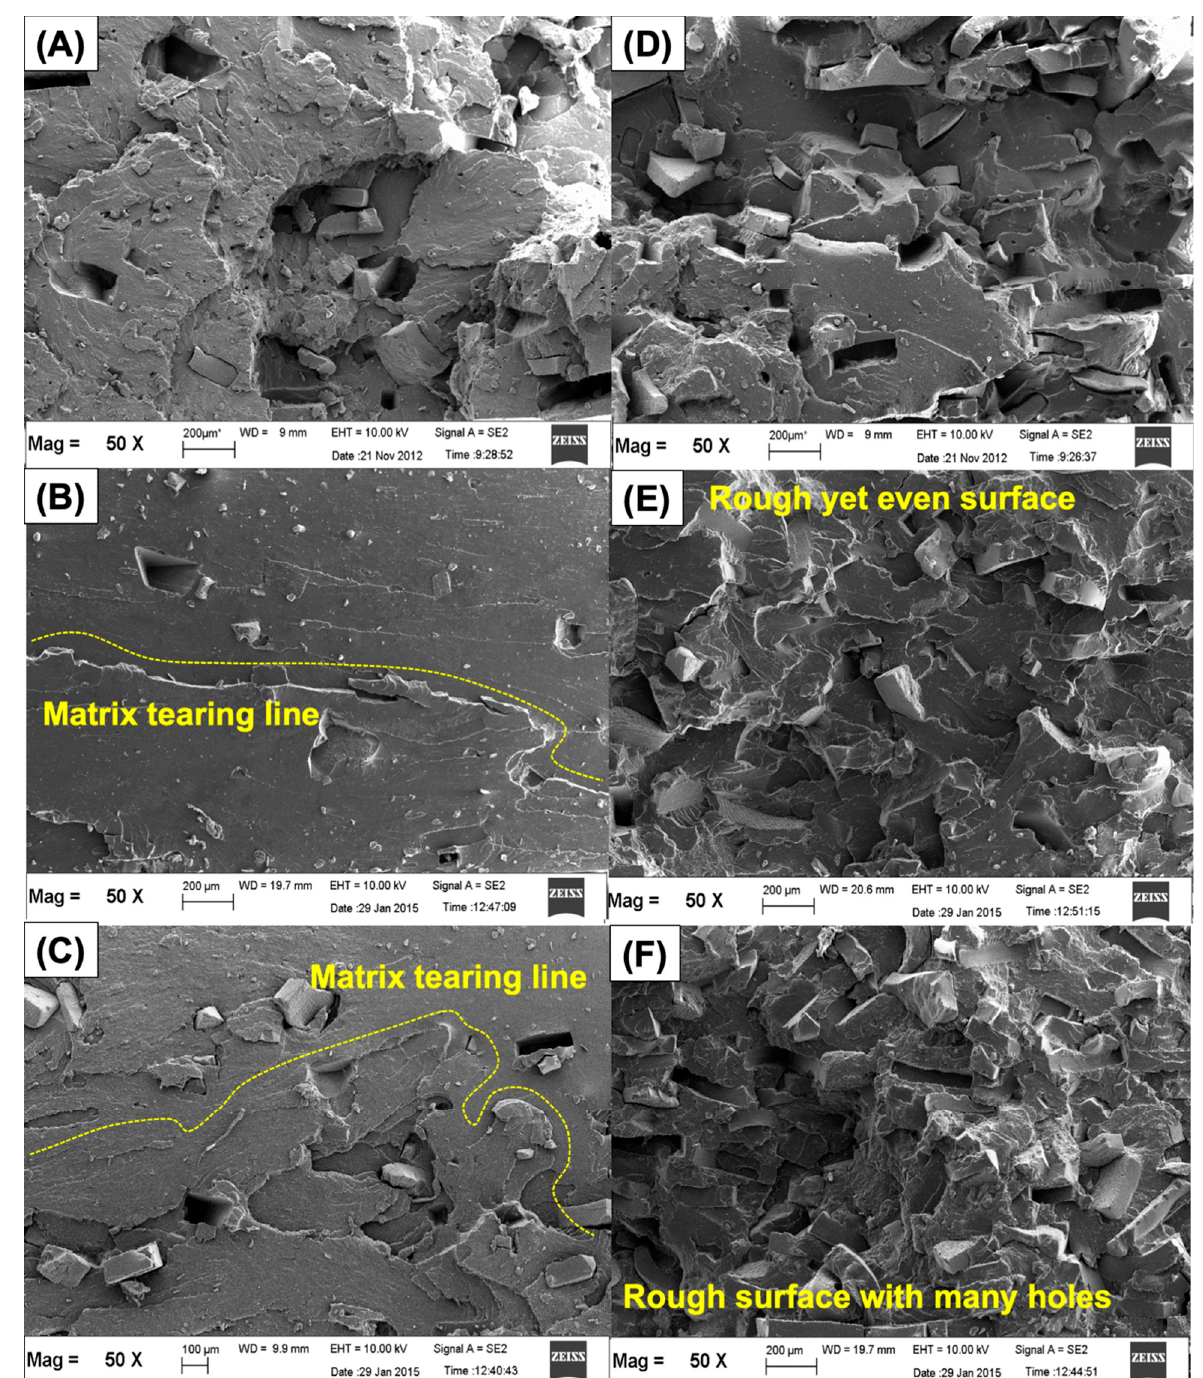
Figure 9. SEM micrographs at 50× magnification of NR/r-NBR blends at 95/5 (phr/phr) cured with S ( A ), DCP ( B ), or S/DCP ( C ); and at 65/35 (phr/phr) cured with S ( D ), DCP ( E ), or S/DCP ( F ).